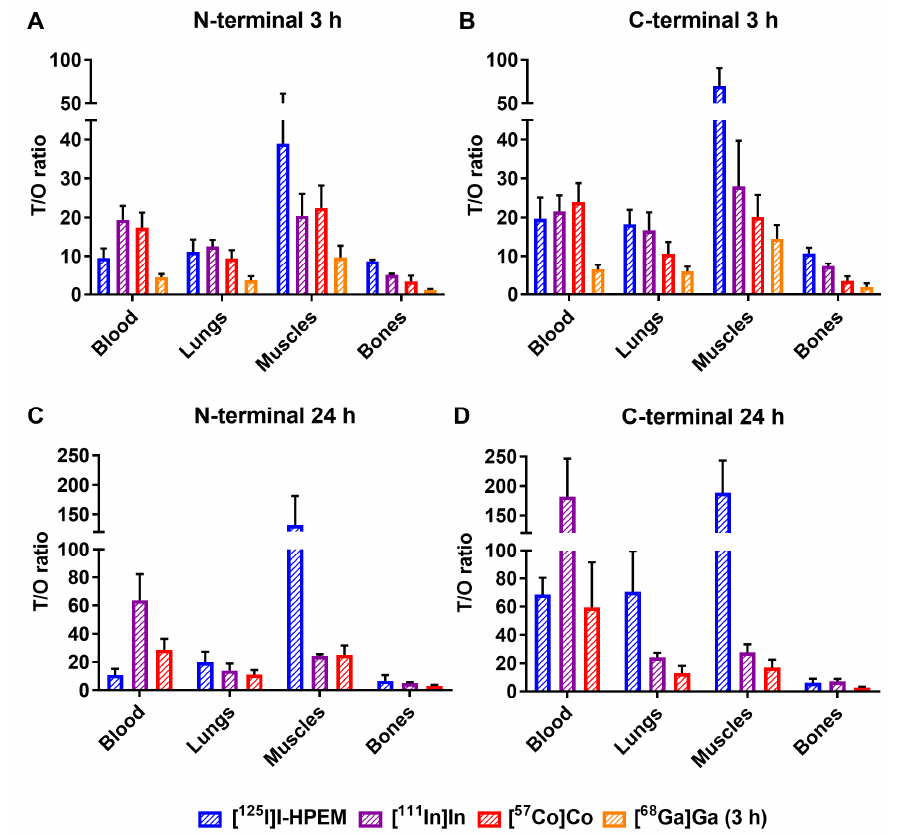
Figure 4. Tumor-to-normal-tissue ratios of DARPin Ec1 variants radiolabeled with [ 125 I]I-HPEM, [ 111 In]In, [ 57 Co]Co and [ 68 Ga]Ga at N - ( A , C ) or C -terminus ( B , D ) in Balb/c nu/nu mice bearing EpCAM-expressing DU145 xenografts at 3 or 24 h p.i. Table 8. Tumor-to-normal-tissue ratios for DARPin Ec1 variants labeled with [ 57 Co]Co, [ 111 In]In or [ 125 I]I-HPEM at N - or C -terminus 24 h p.i. in Balb/c nu/nu mice bearing EpCAM-expressing DU145 xenografts (average from 4 mice ± SD). One-way ANOVA with Bonferroni’s multiple comparisons test was performed to find significant differences between Ec1 variants with the same label position ( N - or C